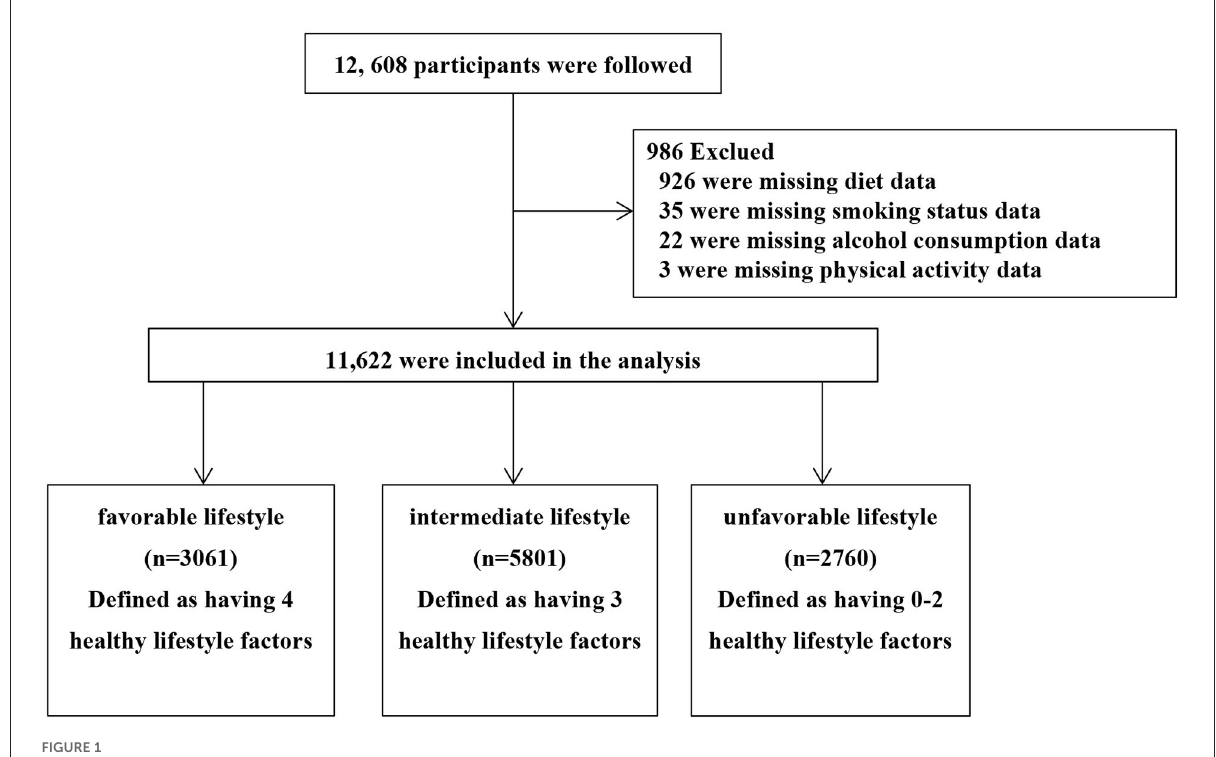
FIGURE1 Study flow